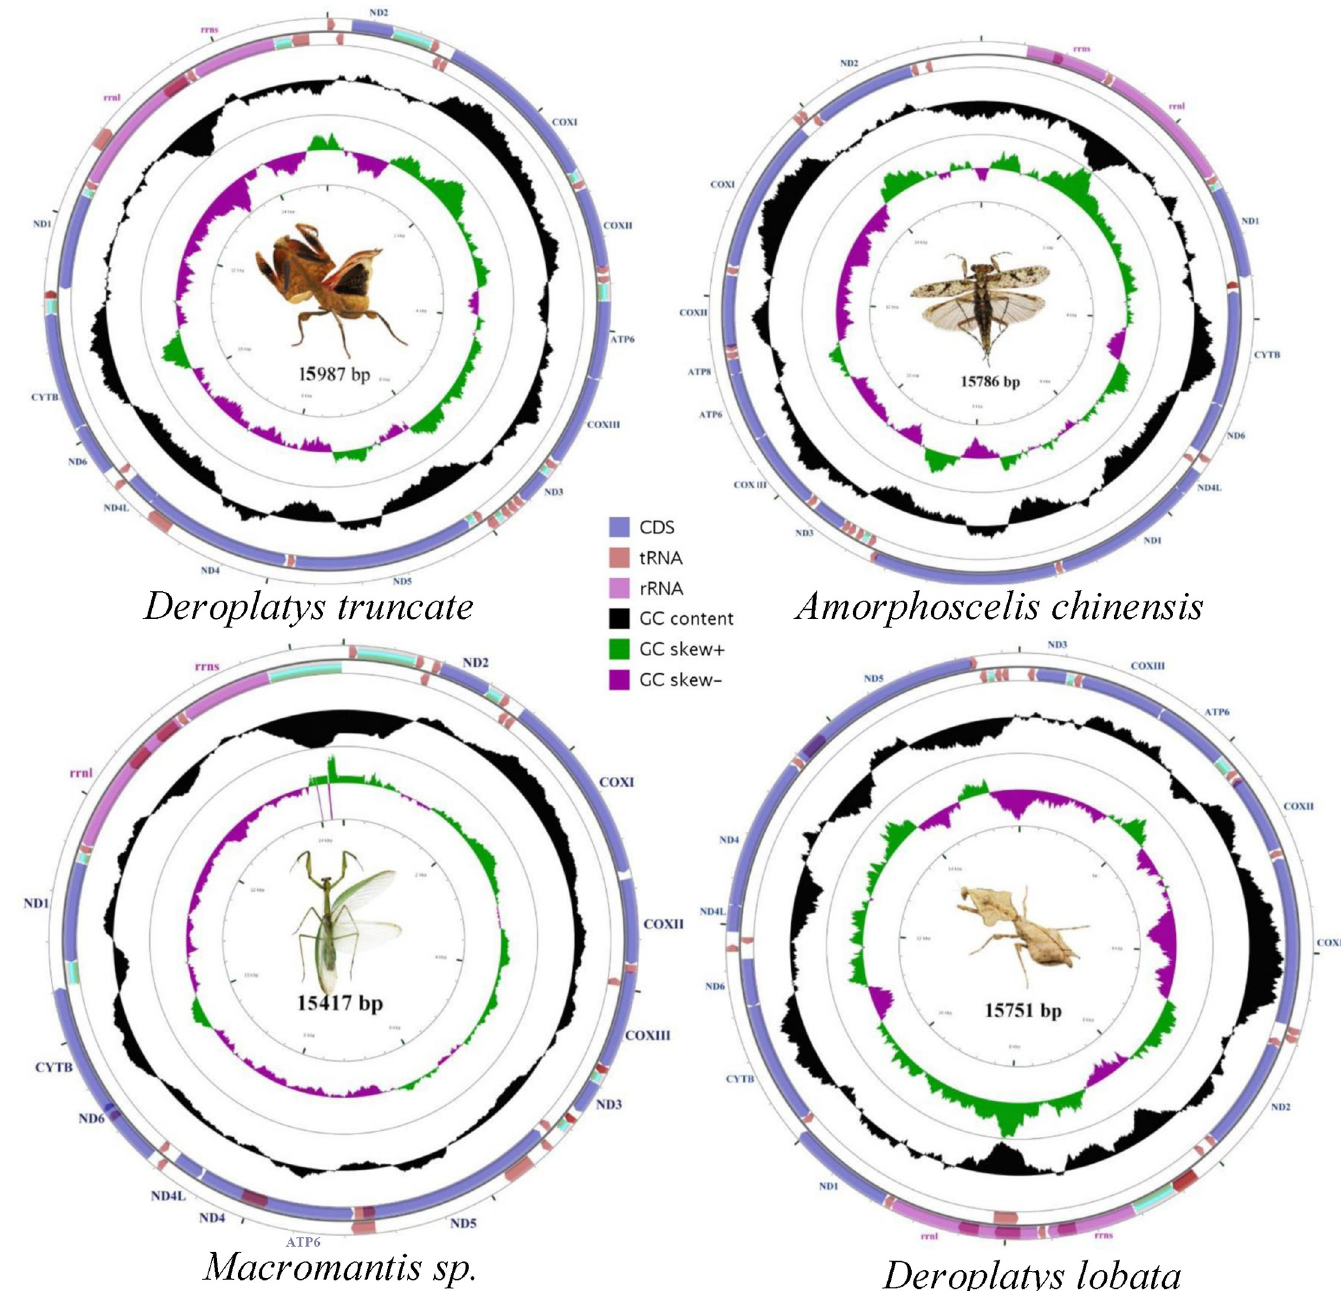
Fig 1. Mitochondrial genomes of Deroplatys truncate , Amorphoscelis chinensis , Macromantis sp. and Deroplatys lobata . Circular maps were drawn with CGView. Arrows indicate the orientation of gene transcription. Protein-coding genes are shown as blue arrows, rRNA genes as purple arrows, tRNA genes as brown arrows and non-coding regions as grey rectangle. Abbreviations of gene names are: atp6 and atp8 for ATP synthase subunits 6 and 8, cox1 - 3 for cytochrome oxidase subunits 1–3, cob for cytochrome b, nad1 - 6 for NADH dehydrogenase subunits 1–6, rrnL and rrnS for large and small rRNA subunits. The GC content is plotted using a black sliding window, as the deviation from the average GC content of the entire sequence. GC-skew is plotted as the deviation from the average GC-skew of the entire sequence. The inner cycle indicates the location of genes in the mitochondrial